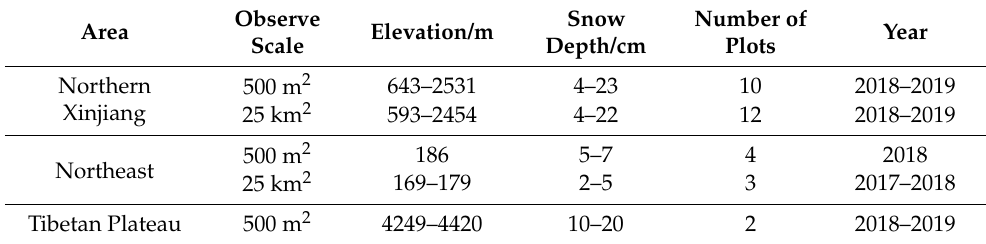
Table 1. Ground observation statistics for snow